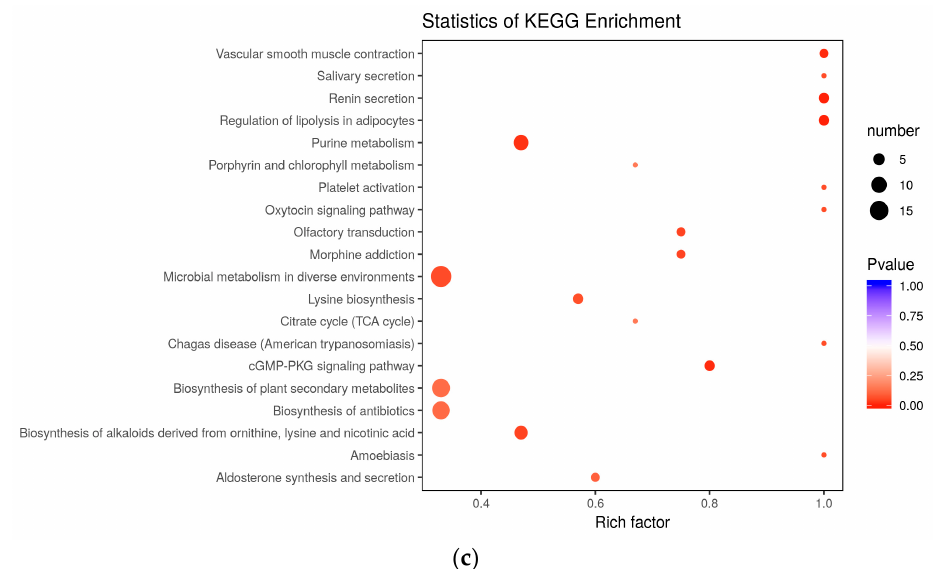
Figure 6. KEGG pathway enrichment analysis of DAMs. ( a ) Pathway enrichment in PEC vs. NEC; ( b ) pathway enrichment in GE vs. PEC; ( c ) pathway enrichment in GE vs. NEC. The x-axis represents the enrichment factor, while the y-axis represents the enrichment pathway. The dot sizes represent the number of differentially enriched metabolites. The statistical analysis of the pathway enrichment was performed using Fisher’s exact test. DAMs, differentially accumulated metabolites; NEC, nonembryogenic staged calli; PEC, primary embryogenic calli; GE, initiation staged embryos with globular-like enriched.